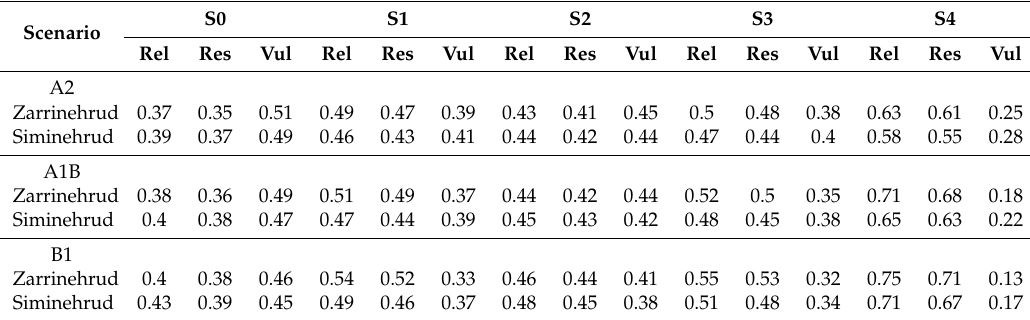
Table 5. Performance criteria of reliability, resilience and vulnerability for